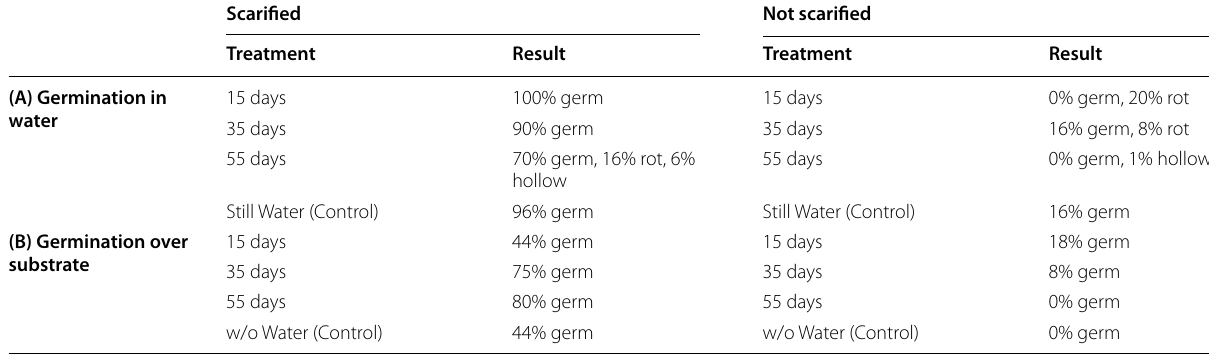
Table 3 Summary of results for the (A) ‘Germination in water’ and (B) ‘Germination over substrate’ experiments. Each seed was individually assessed after completion of each experiment, according to the following categories: "Germ", seeds that germinated during the experiment and were viable at the end; "Rot", rotten seeds at the end of the experiment; "Hollow", seeds with only tegument (no embryo) at the end of the experiment. "Control still W" is a result from a control experiment, where seeds were germinated in water without motion. "w/o W" is a result from a control experiment in which seeds were germinated without being immersed in water. More details in Fig.